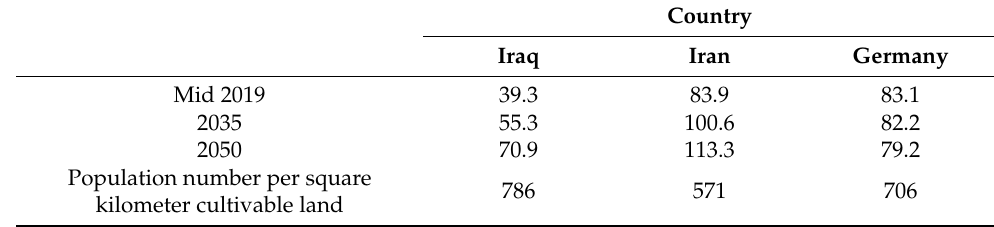
Table 1. Present and future prospective population number (in million) in Iraq, Iran, and Germany *.